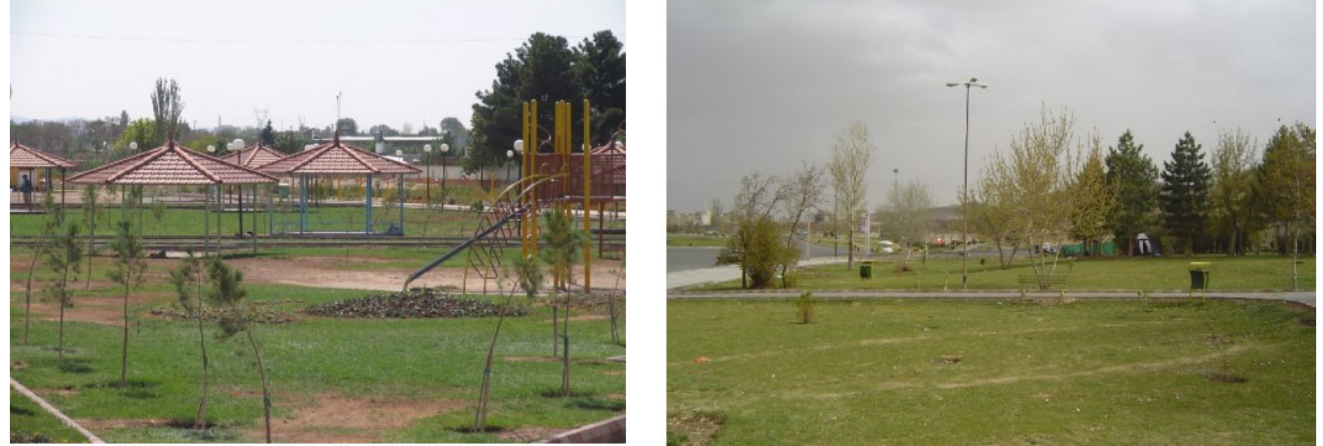
Figure 2: Pictures of Urban Parks in Tabriz, Iran Fig. 2. Pictures of Urban Parks in Tabriz, Iran